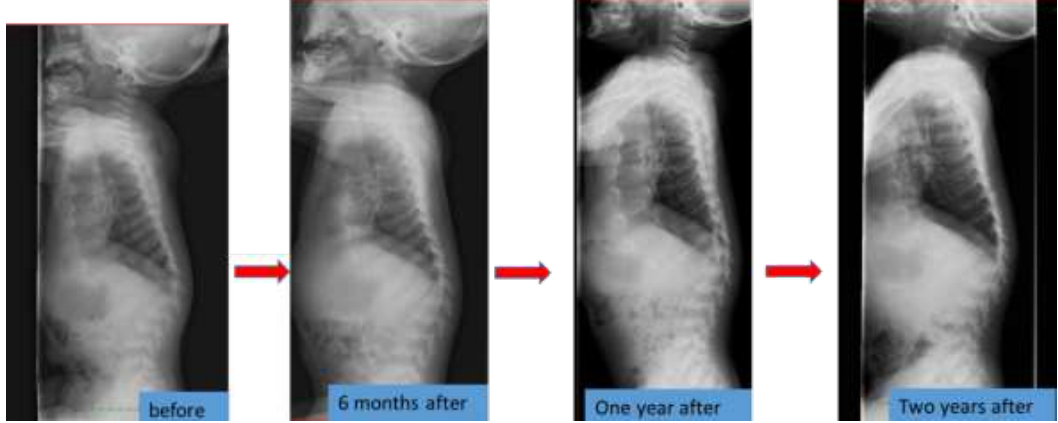
Figure 2. The spine X-ray findings before and after the enzyme replacement therapy in a Japanese boy with MPS IVA.